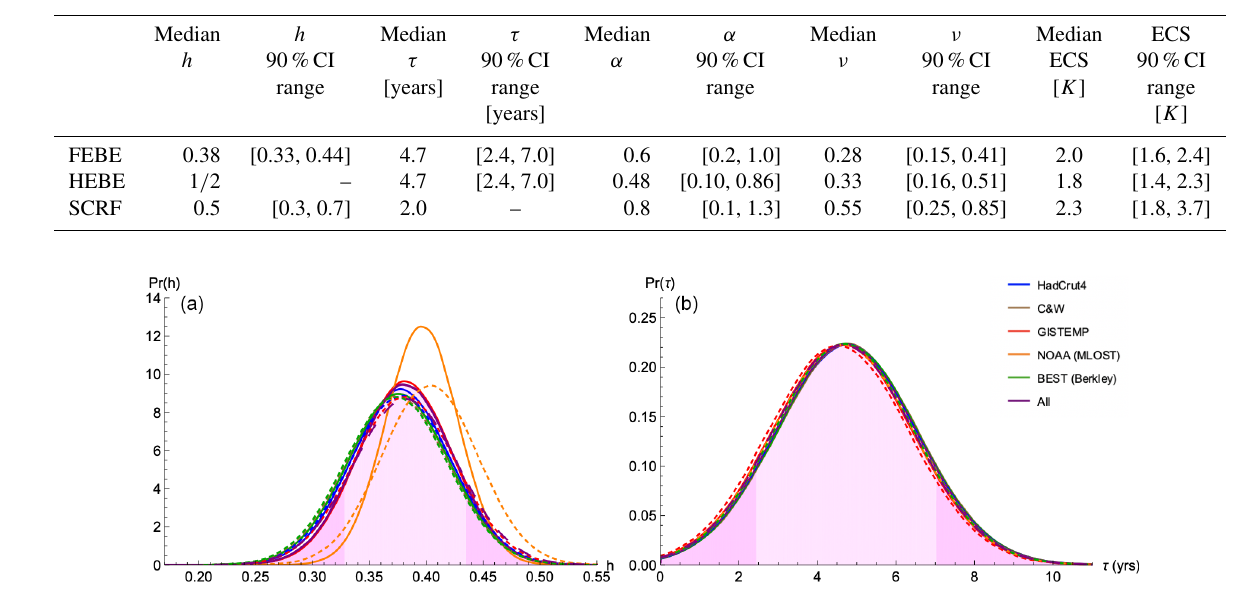
Figure 3. For each observational dataset and their average, PDFs are shown for the model parameters: the scaling parameter h (a) and the transition time τ (b) . Shown are the PDFs for parameter estimation based on both F Aer (solid) and F Aer (dashed). The average PDF RCP SSP of the five observation datasets using F Aer is shown as the main result with shading, with darker 5% RCP